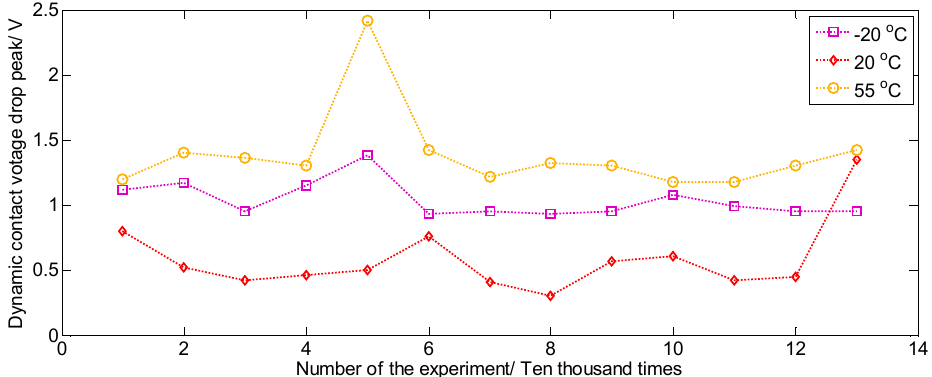
Figure 3. The variation curve of static contact voltage drop at different temperatures.